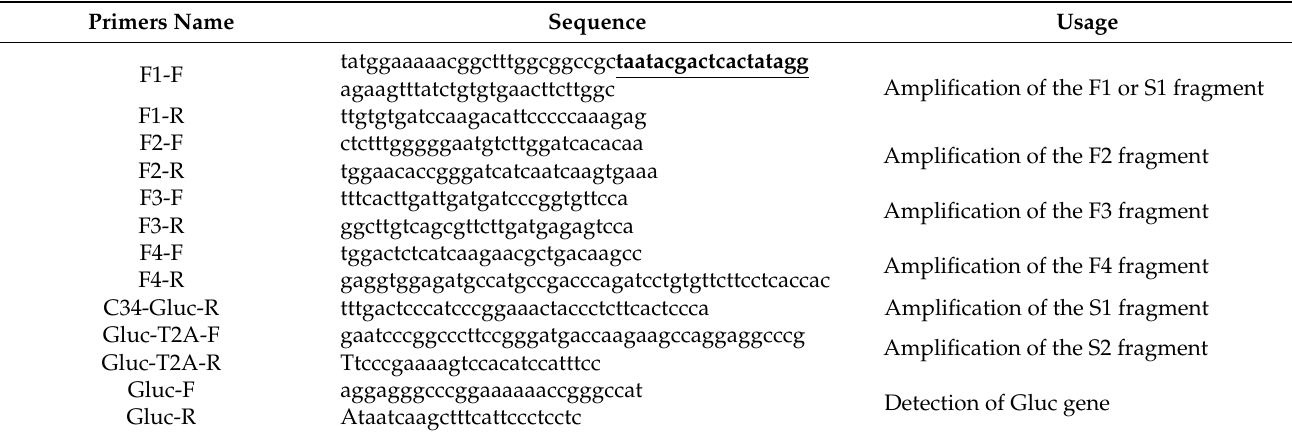
Table 1. The primers used in this